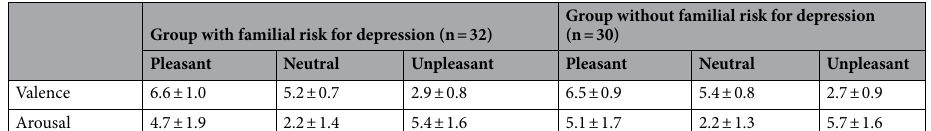
Group with familial risk for depression (n =